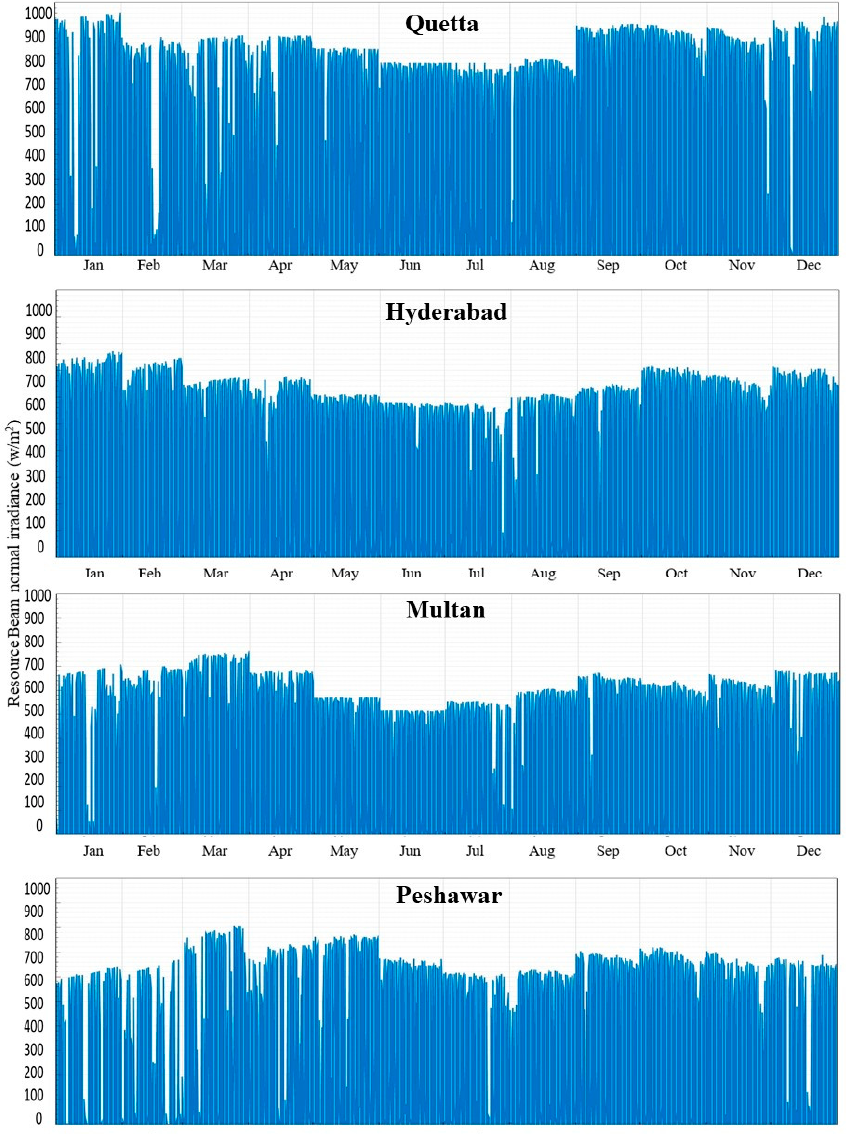
Figure 12. DNI of the proposed locations.